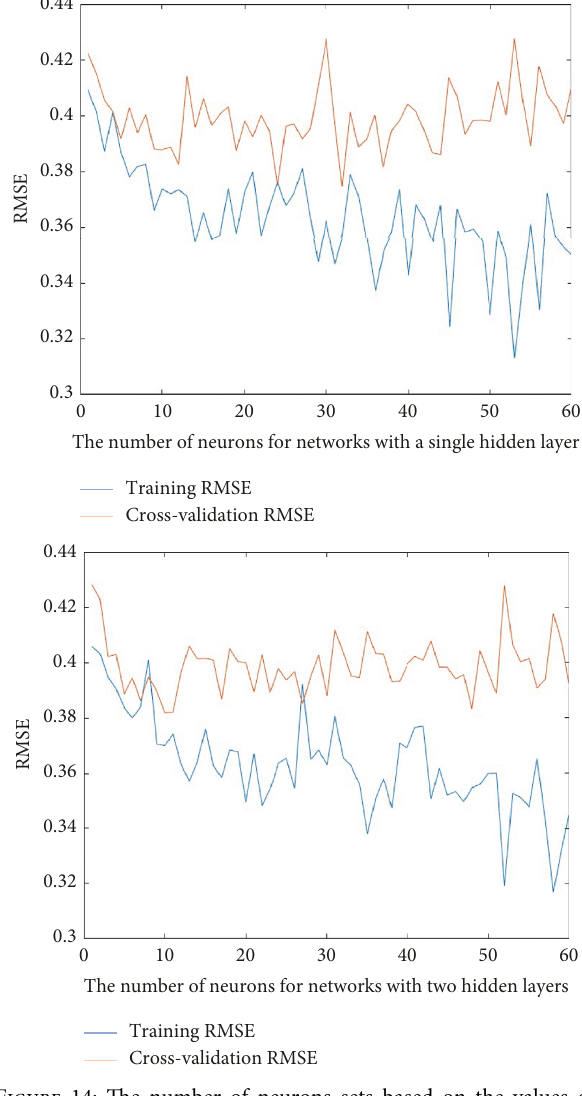
Figure 14: The number of neurons sets based on the values of RMSE for the developed models.